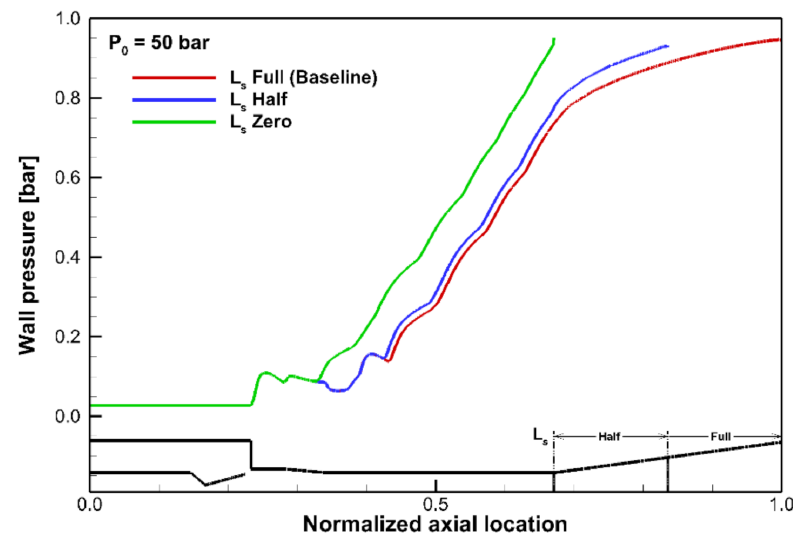
Figure 12. Wall pressures with various diverging section length ratios.